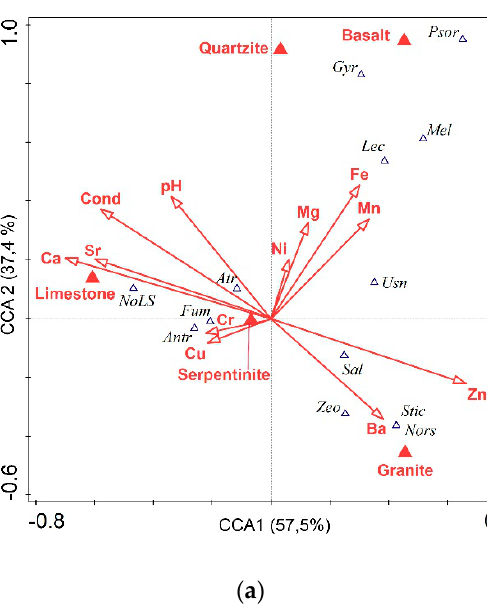
Figure 4. Ordination of the rock types from the different sampling localities ( n = 18) on the basis of pH, conductivity and metal content.